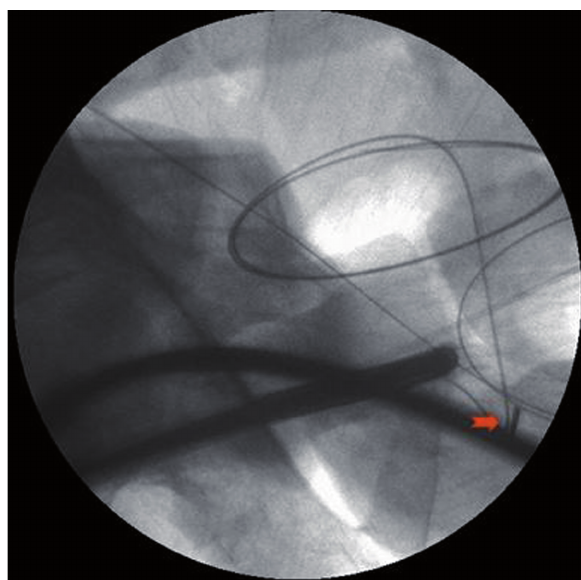
Figure 1 - Fluroscopic view of broken blade in bulbar urethra.